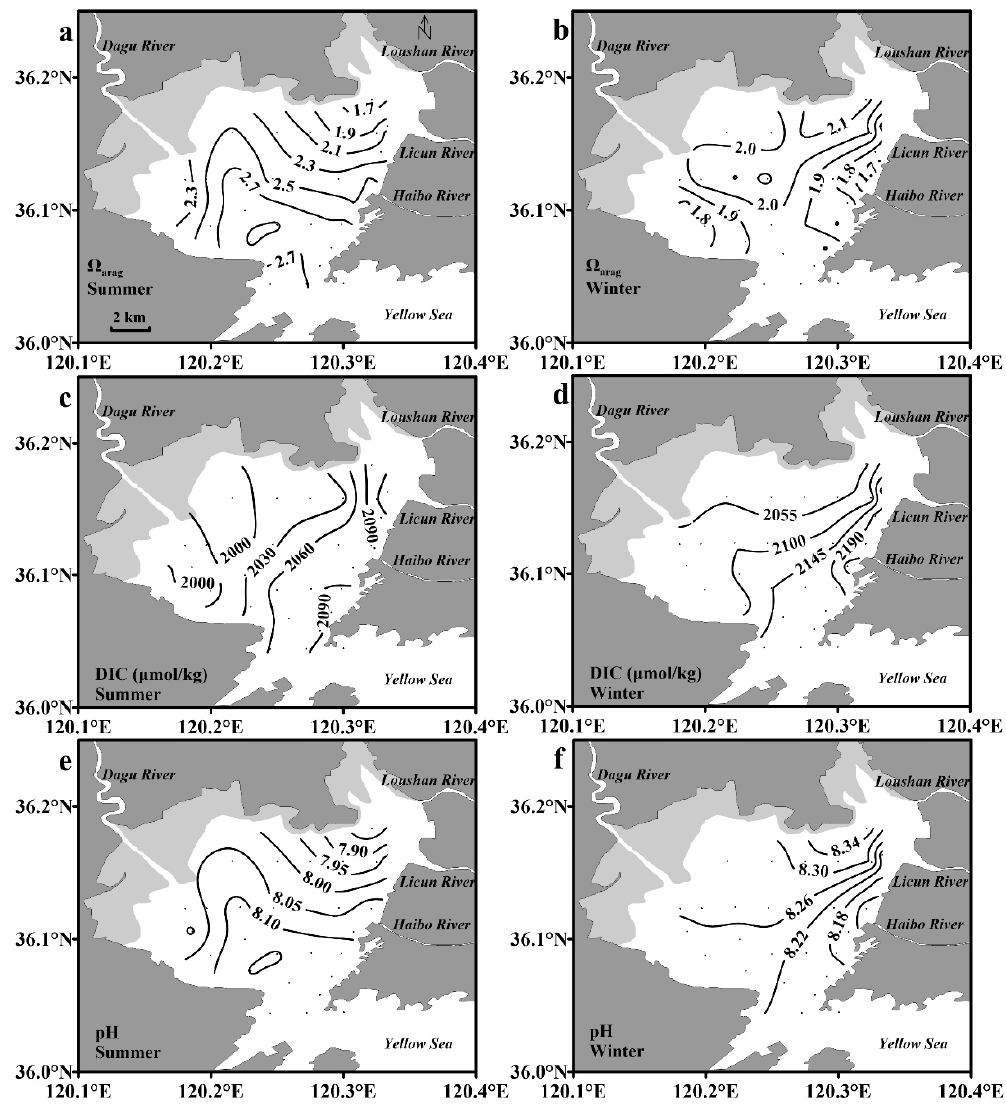
Figure 3. Distributions of seawater surface Ω arag ( a , b ), DIC ( c , d ) and pH ( e , f ) in JZB during summer ( a , c , e , on 28 June 2017) and winter ( b , d , f , on 17 January 2017).